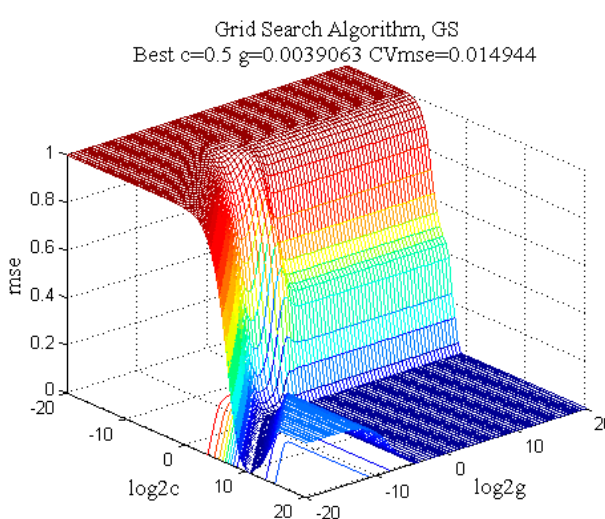
Figure 4. The 3D view of the optimization results for parameters c and g by grid search method with seven-fold cross validation.